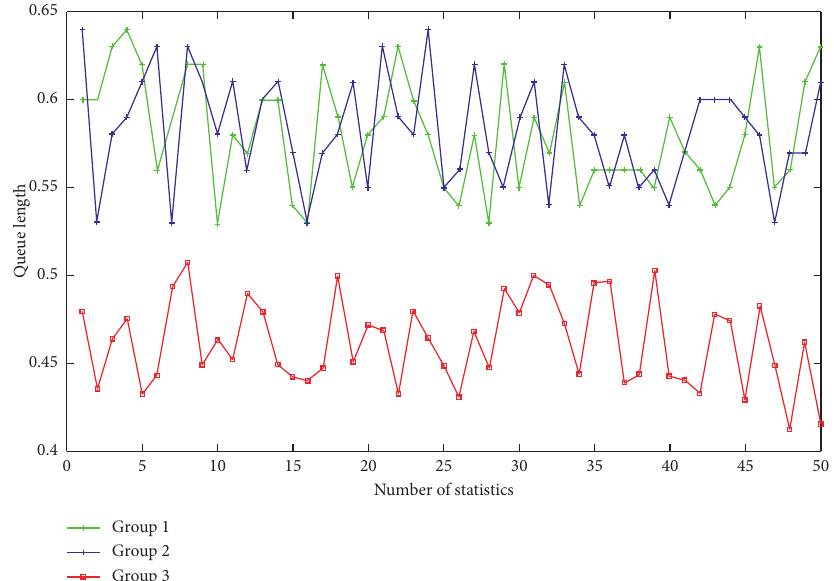
Figure 10: The maximum queue length of the system under a low congestion level.